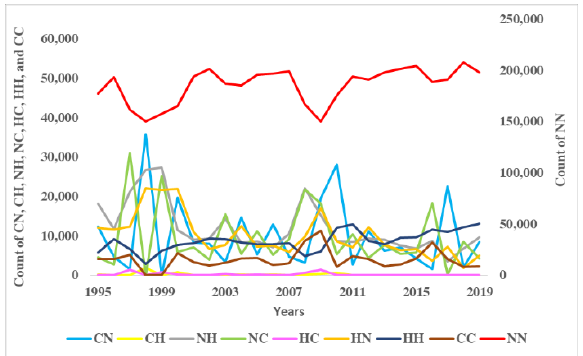
Figure 4. Count of grids for Cold to Normal, Cold to Hot, Normal to Hot, Normal to Cold, Hot to Cold, Hot to Normal, Hot to Hot, and Cold to Cold transition types (at first vertical axis: left) and Normal to Normal transition type (at secondary vertical axis: right) in Davao City from 1994-2019.